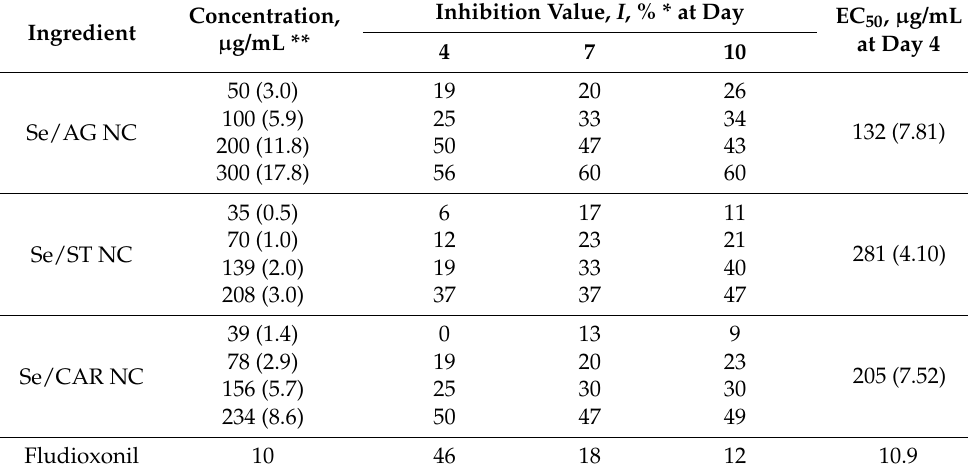
Table 1. Fungicidal activity of selenium (Se) nanocomposites (NCs) against fungus Phytophthora cactorum VKM